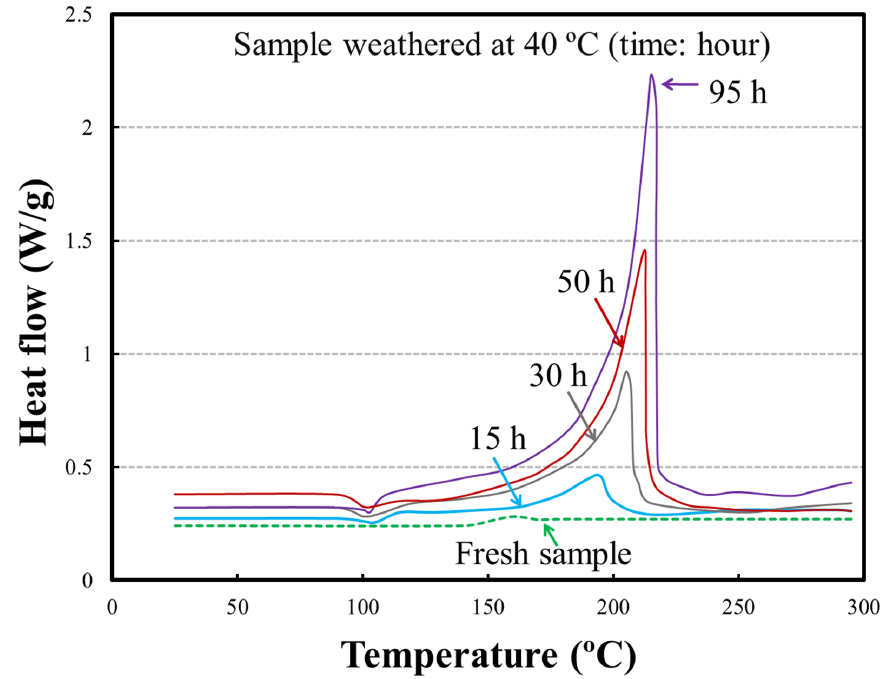
Figure 2. Effect of weathering in Stage A at 40 °C on DSC exotherms (adapted from Rosenblum and Figure 2. E ff ect of weathering in Stage A at 40 ◦ C on DSC exotherms (adapted from Rosenblum and Spira [18]). Spira